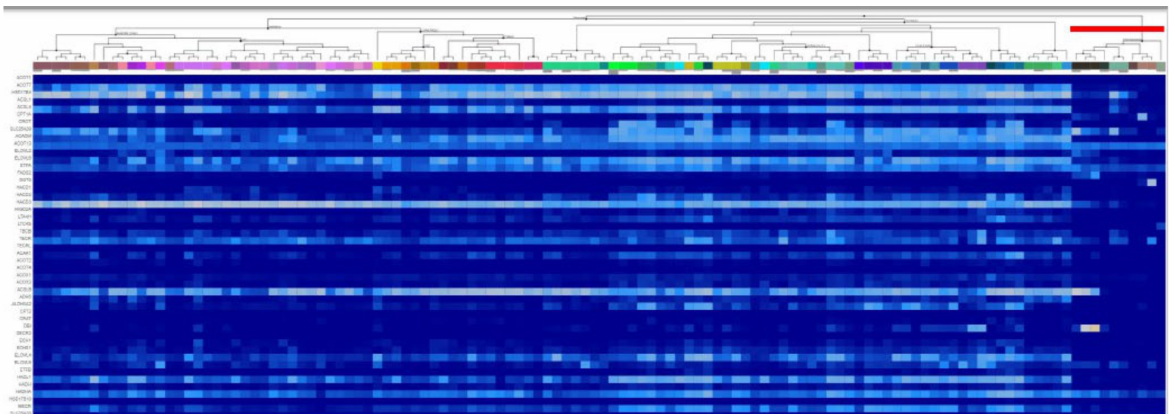
Figure 6. RNA-Seq data obtained from the Allen Brain Atlas, looking at the expression of genes (indicated on the left) participating in peroxisomal carnitine shuttle and fatty acid oxidation (beta-, omega-3, and omega-6), as a function of cell types. Glial cell types are indicated by the red dash in the top right corner. Image credit: Allen Institute: https: //celltypes.brain-map.org/rnaseq/human (accessed on 25 May